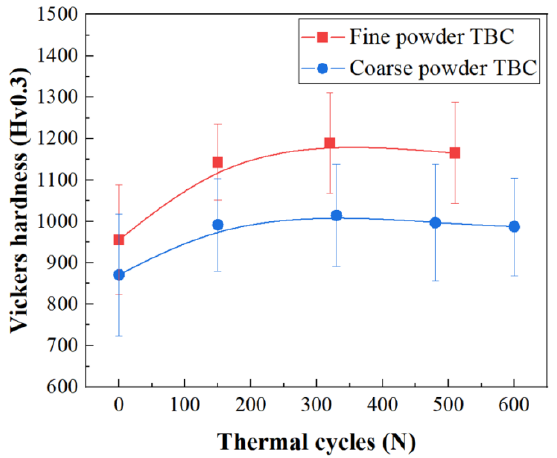
Figure 12. Hardness evolution of two kinds of YSZ coatings during thermal